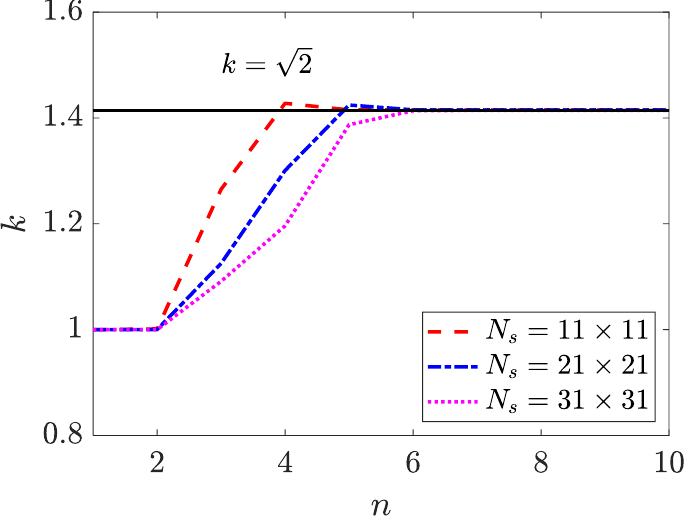
k with iteration steps for the 2D constant parameter identi-